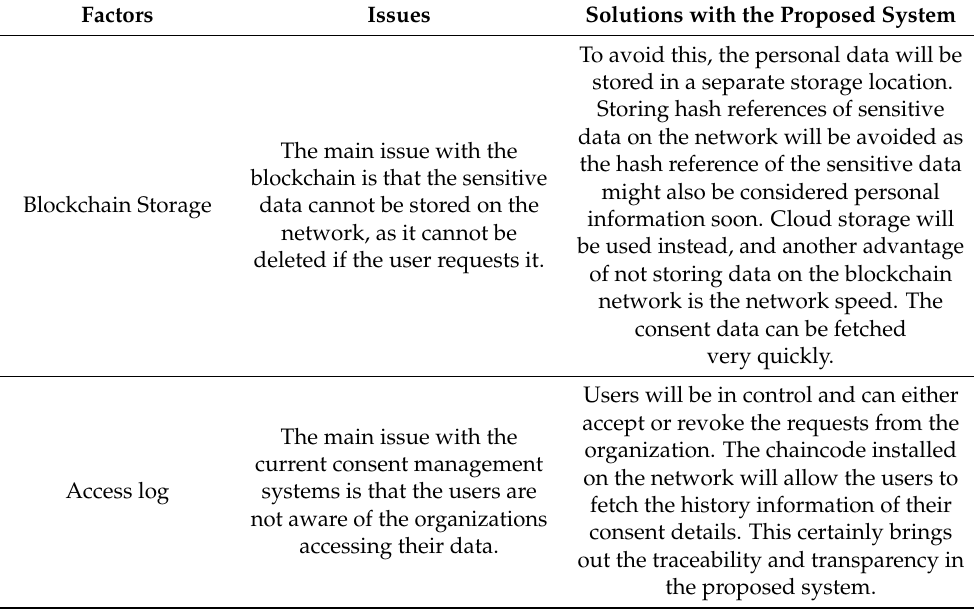
Table 1. Features of the proposed